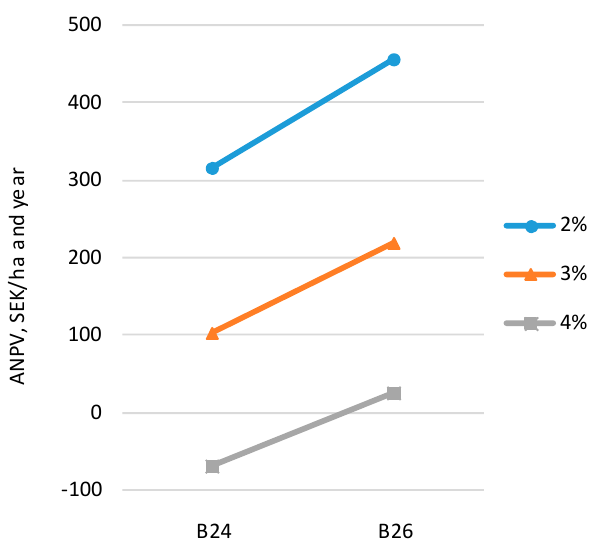
Figure 3. Annuity of net present value (ANPV) (contribution to land, management, and risk; CLM&R) of naturally regenerated birch on site quality classes (SQCs) B24 and B26 at real interest rates of 2%, 3%, and 4%.